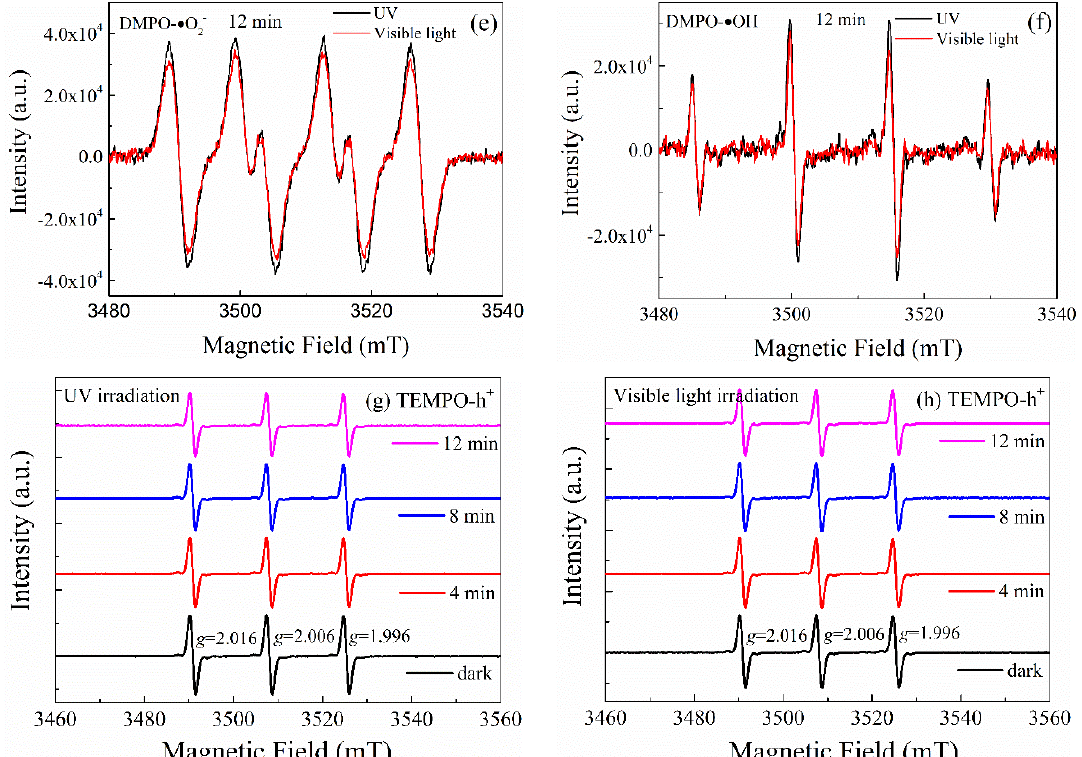
Figure 7. Electron spin resonance (ESR) spectra of radical adducts trapped by 5,5-dimethyl-1- pyrrolinen-oxide (DMPO) for the detection of O 2 − in methanol dispersions and OH in aqueous dispersions and by 2,2,6,6-tetramethylpiperidine-1-oxyl (TEMPO) for the detection of photo-generated h + in aqueous dispersions under ( a ), ( c ) and ( g ) UV and ( b ), ( d ) and ( h ) visible light irradiation; comparison of ( e ) DMPO–O 2 − and ( f ) DMPO–OH adducts after 12 min of illumination with UV